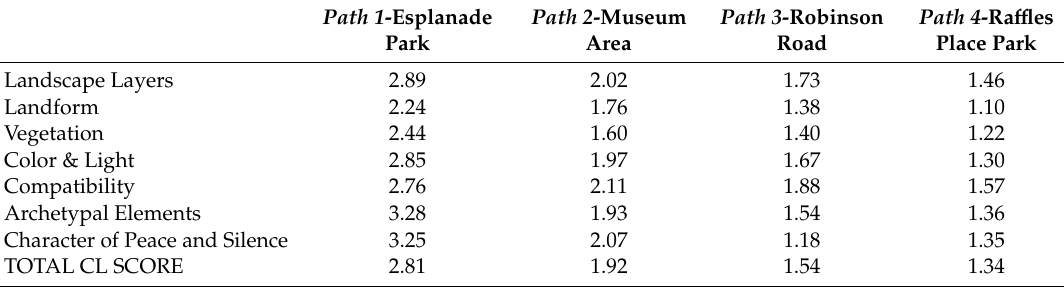
Table 1. Total CL scores (1-6 point scale) per each of 4 paths and each of the CLM